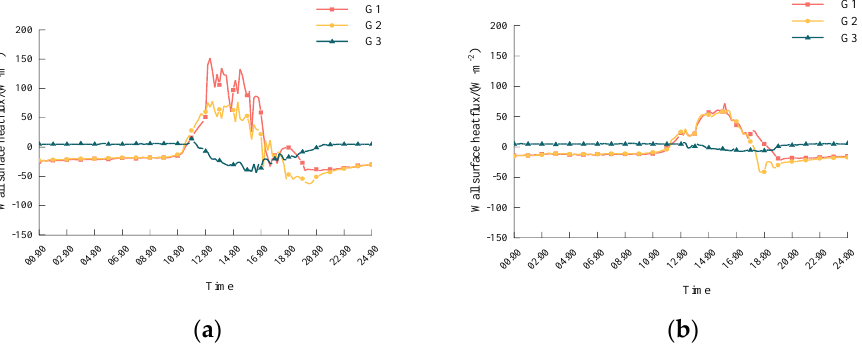
Figure 9. Changes in heat flux on the wall surface of CSGs under typical weather. ( a ) Sunny day (20 February 2022). ( b ) Cloudy day (18 February 2022).